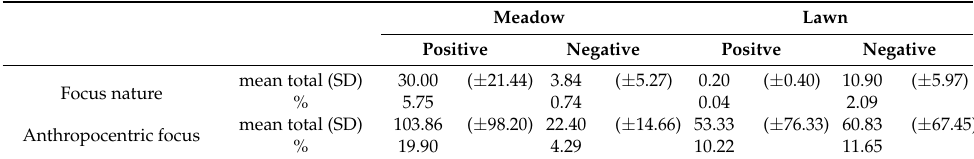
Table 3. Combination of results of Table 2 after re-arrangement of the answers, forming the new categories “focus nature” and “anthropocentric focus”. Positive and negative entries are presented in mean numbers of mentions per category and percentages. n =